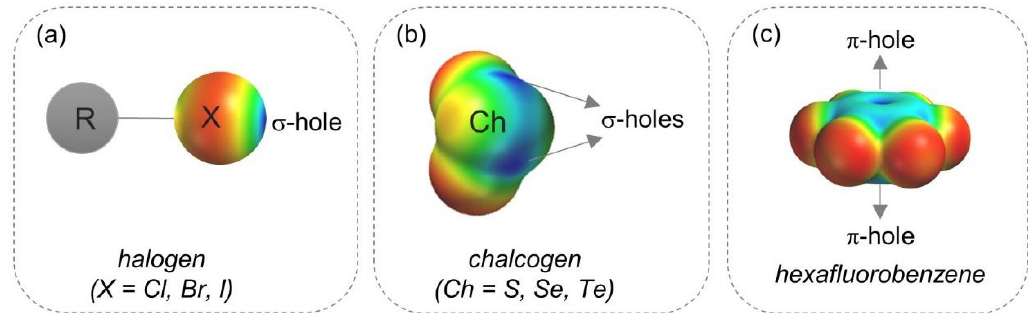
Figure 1. Location of halogen ( a ) and chalcogen ( b ) σ -holes and π -hole ( c ). For the V S representations, colors towards red depict negative V S while colors towards blue depict positive V S , and colors in between (orange, yellow, green) depict intermediate values.